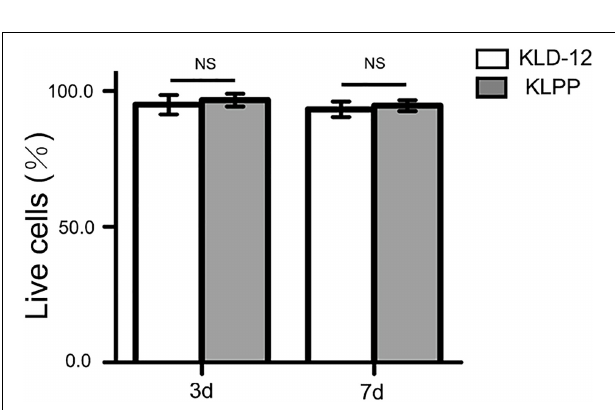
FIGURE 4 | Quantification assay of cell survival rates. Cell viability = live cells/(live cells + dead cells) × 100%. There was no significant difference in cell survival rates between KLD-12 and KLPP hydrogels after 3 and 7 days of culture ( n = 5, mean ± SD. KLD-12 vs. KLPP: 95.2 ± 3.6% vs. 96.5 ± 2.4% on day 3; 93.4 ± 2.9% vs. 94.5 ± 1.9% on day 7. NS: no significance, P >